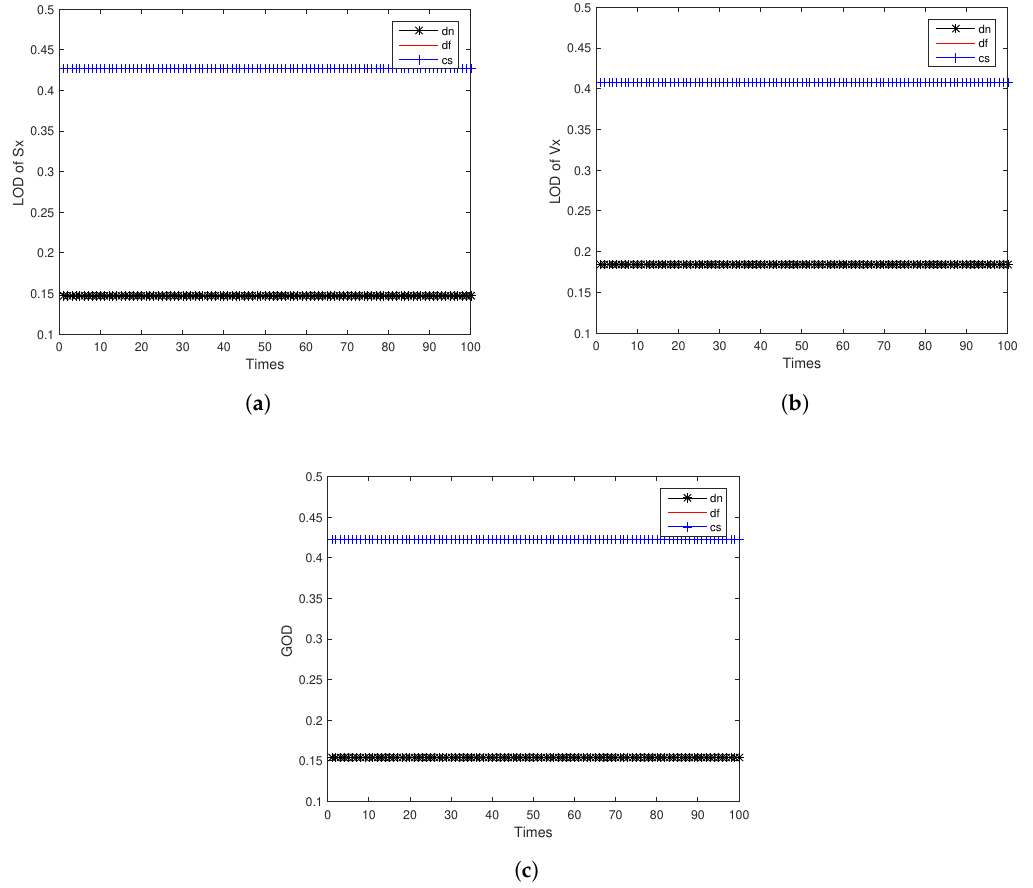
Figure 7. Observable degree comparison among different fusion methods for same index 1: ( a ) LOD of Sx; ( b ) LOD of Vx; ( c )